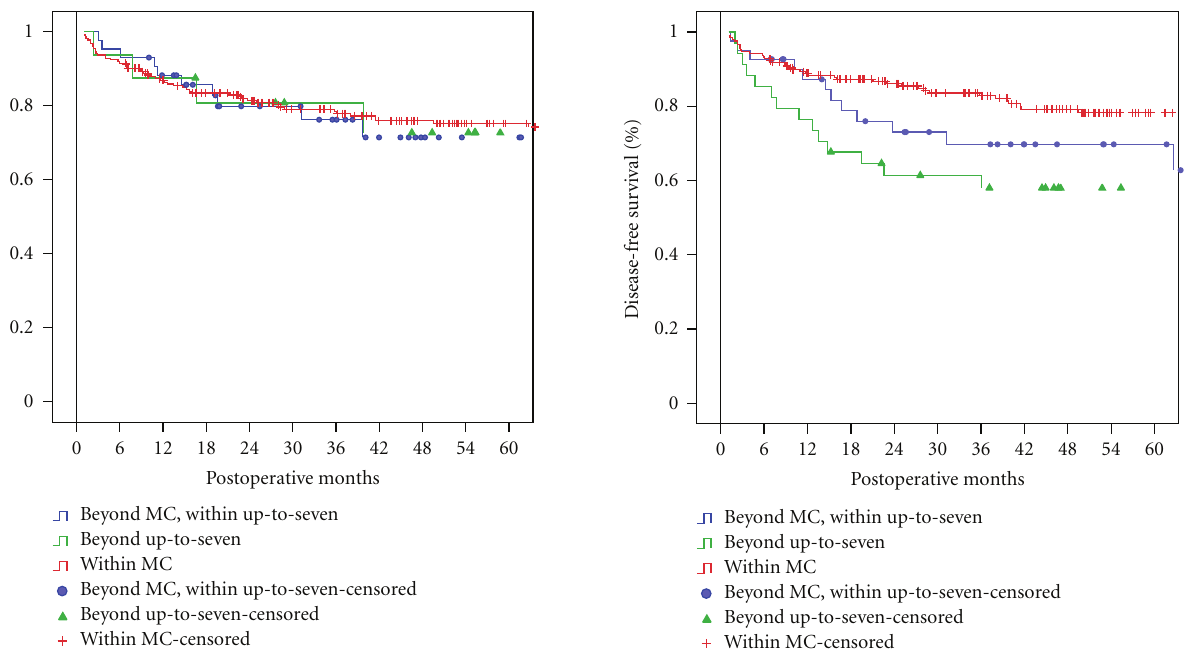
Figure 2: Disease-free survival of patients within histological MC ( n = 208), beyond histological MC but within up-to-seven criteria ( n = 41), and beyond histological up-to seven criteria ( n = 34) ( P = .